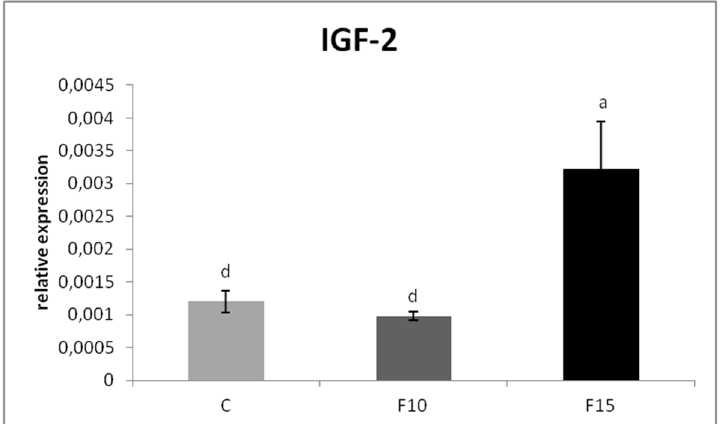
Figure 3. Relative expression of IGF-2 gene in cecum of laying hens treated with fermented feed. Results at each time point are the median of 2 – Δ Cq . Means with different superscripts are significantly different ad p < 0.001.